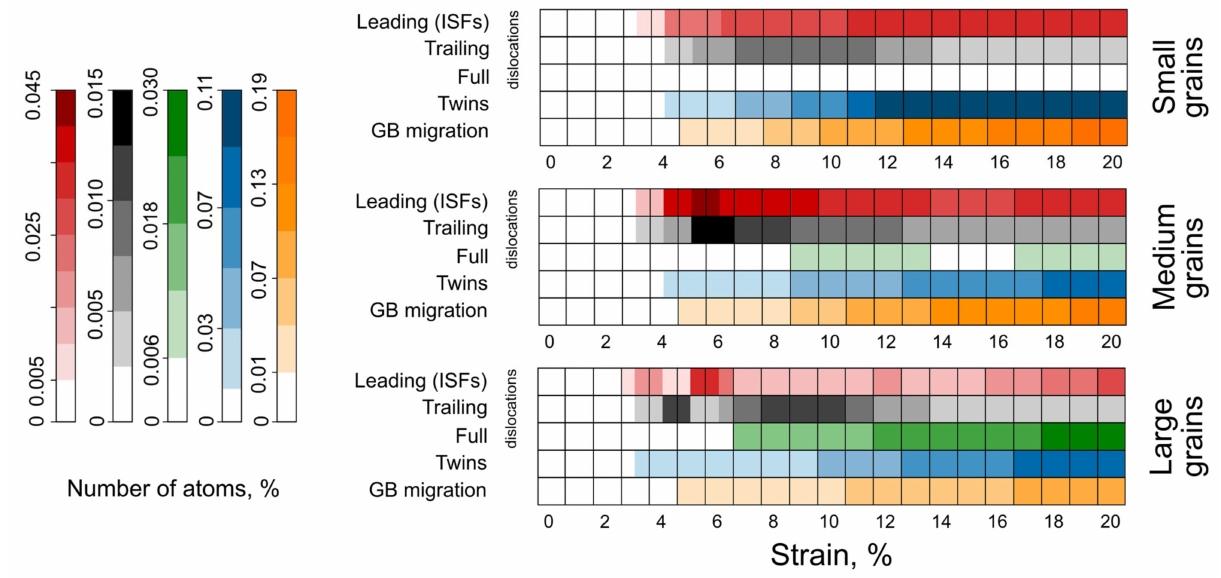
Figure 11. Deformation map showing the contribution of various mechanisms to plasticity develop- ment in different-sized grains of a deformed gradient nanograined